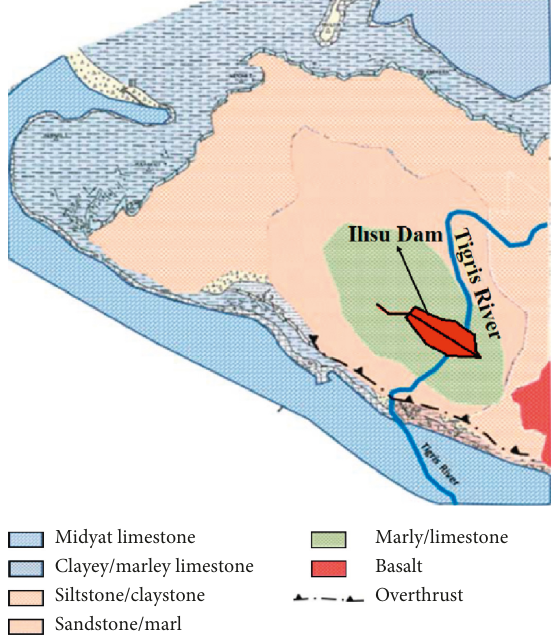
Figure 3: Geology of the Ilısu hydraulic project.